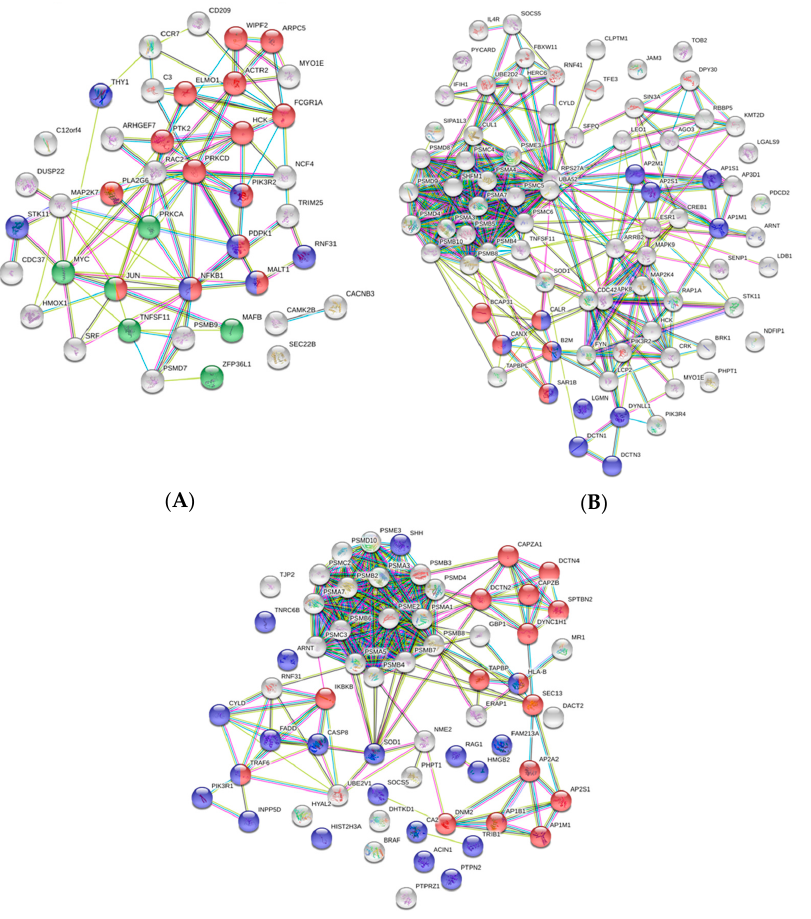
Figure 4. The protein–protein interaction (PPI) network of the set of DEGs/DEPs identified in the overrepresented GO Immune System Process terms. PPI networks were constructed using the STRING software. ( A ) The PPI network of identified DEGs from the HK-RBC transcriptome profile. ( B ) The PPI network of identified DEGs from the PB-RBC transcriptome profile. ( C ) The PPI network of identified DEPs from the PB-RBC proteome profile. Nodes represent proteins, while edges denote the interactions between 2 proteins. Di ff erent line colors represent the evidence types used in predicting the associations: gene fusion (red), gene neighborhood (green), gene co-occurrence (blue), co-expression (black), from curated databases (teal), experimentally text-mining (yellow), determined (purple), or protein homology (lilac). The PPI enrichment p -value was < 1.0 − 16 for the 3 networks represented. Red nodes denote proteins implicated in ( A ) the Fc receptor signaling pathway (GO:0038093), ( B ) antigen processing and presentation of peptide antigen via MHC class I (GO:0002474), and ( C ) antigen processing and presentation of exogenous peptide antigen (GO:0002478). Blue nodes denote proteins implicated in ( A ) T cell receptor signaling pathway (GO:0050852), ( B ) antigen processing and presentation of exogenous peptide antigen (GO:0002478), and ( C ) regulation of hemopoiesis (GO:1903706). Green nodes denote proteins implicated in the regulation of myeloid leukocyte di ff erentiation